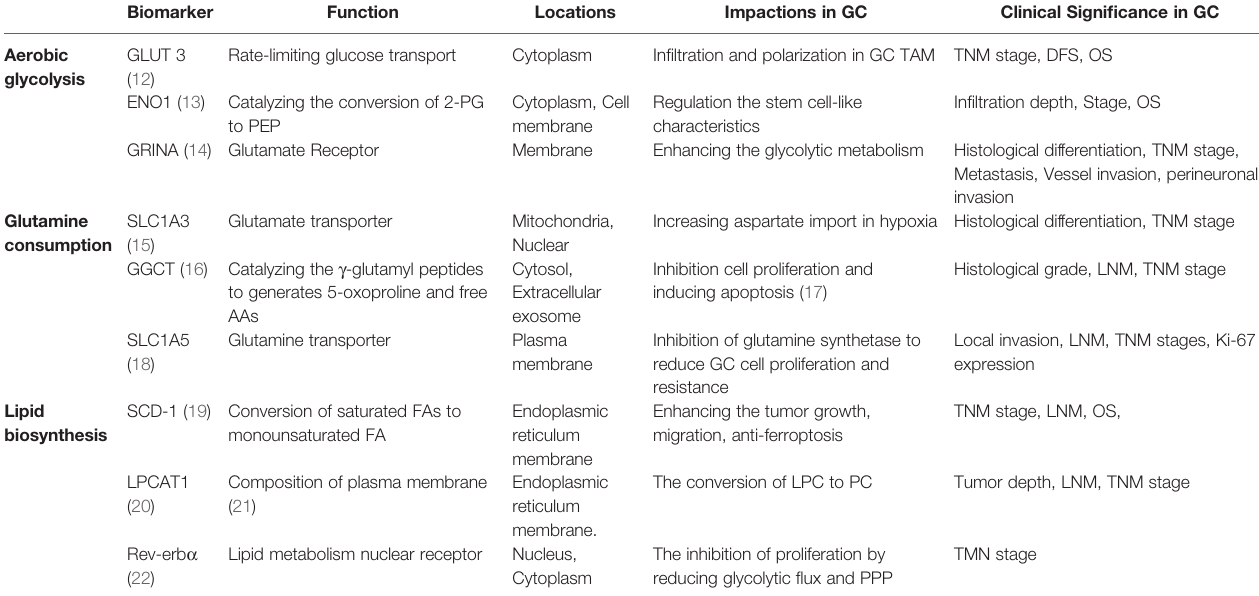
TABLE 1 | Biomarker of metabolic reprogramming in